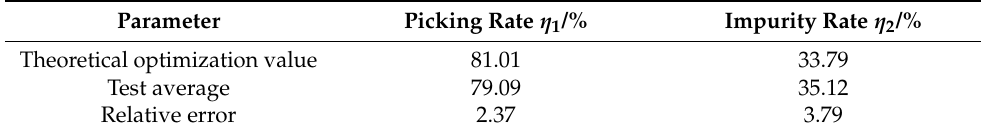
Table 6. Comparison between the optimum theoretical and test results.